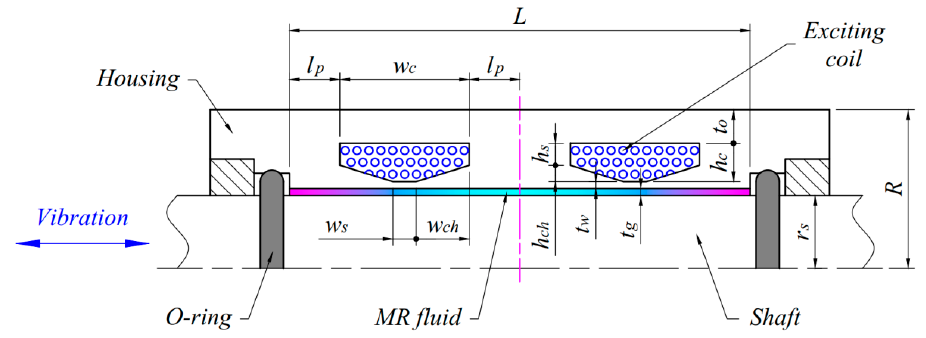
Figure 6. Schematic diagram of the shear-mode MR damping part.